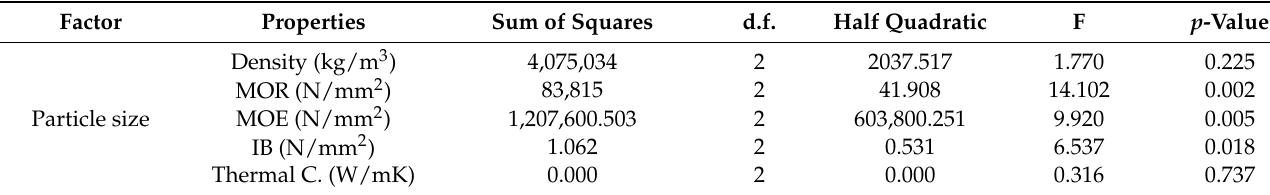
Table 6. ANOVA of the results of the